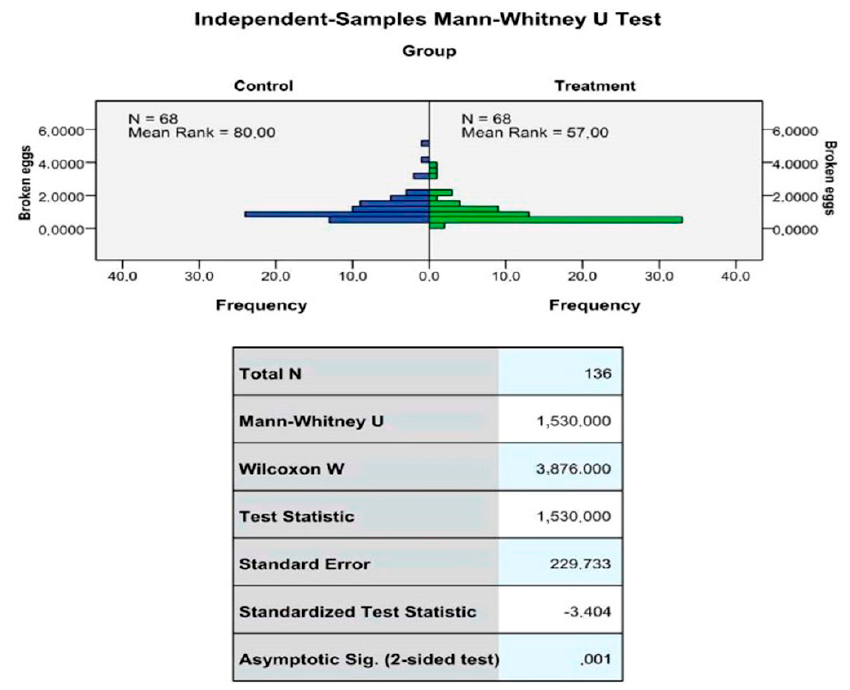
Figure 2. According to the Mann-Whitney U test, there is a statistically significant di ff erence based on the p -value (Asymptotic Significance (two-sided test) = 0.001). The FDA-supplemented group (Mean Rank of 57.00) reported a lower number of broken eggs compared to control group (Mean Rank of 80.00).